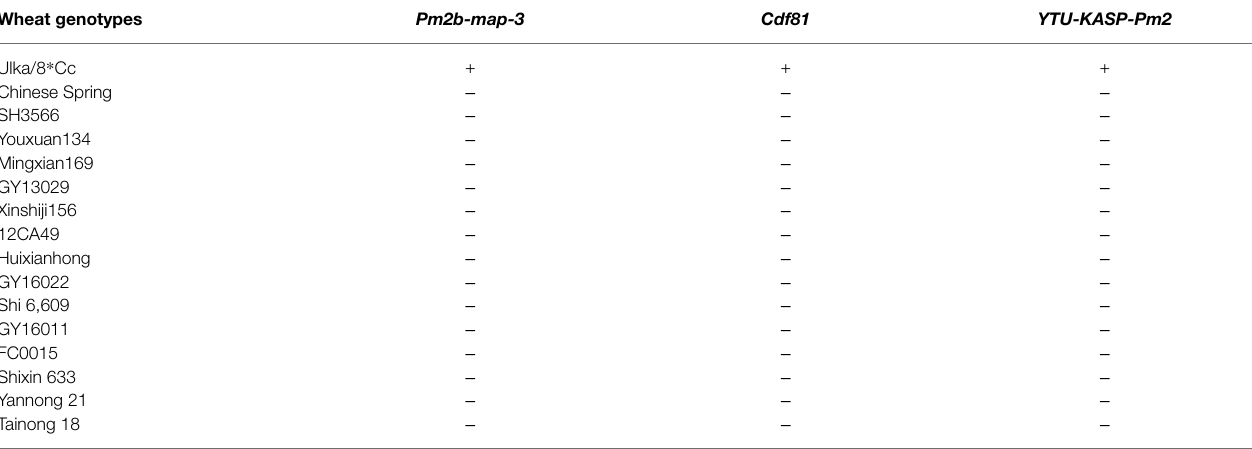
TABLE 4 | Evaluation of Pm2 -diagnostic and linked markers on Ulka/8 * Cc ( Pm2a donor) and 15 susceptible wheat cultivars/breeding lines in marker-assisted selection (MAS) breeding. Wheat genotypes